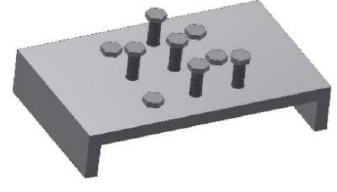
Figure 3. The test structure. Table 1. Smart phone camera specifications.